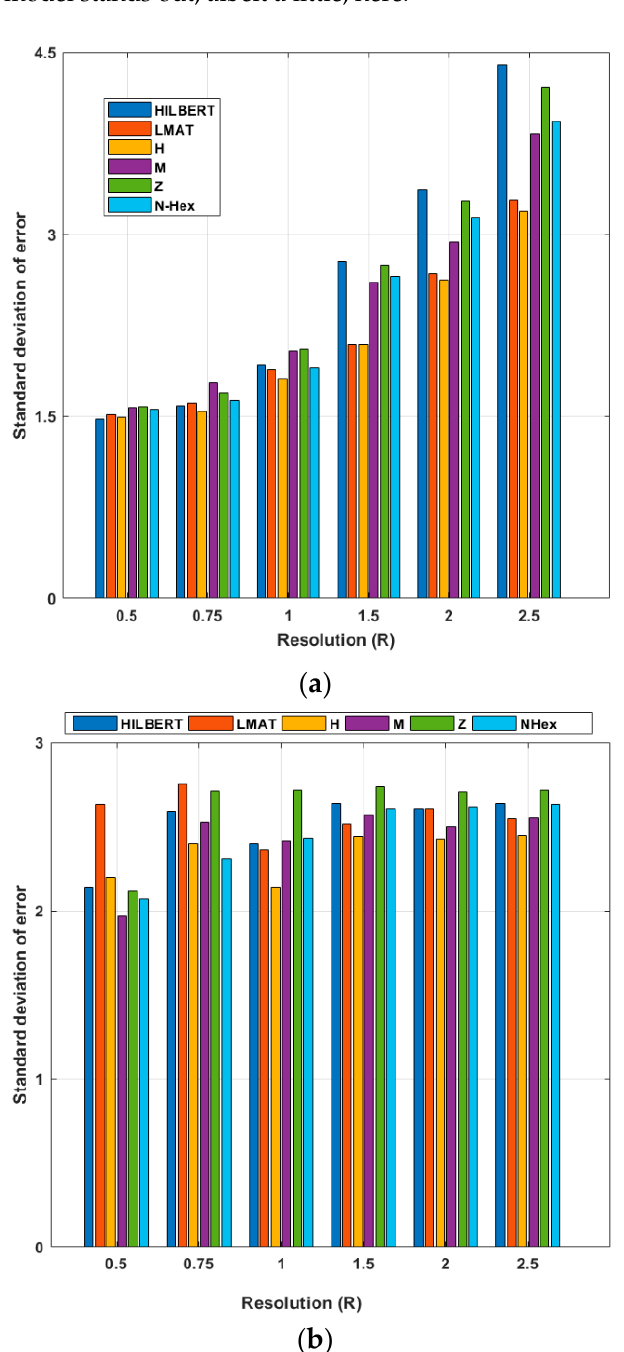
Figure 15. Std of errors of the path planning models according to resolution ( σ = 7) ( a ) WCL, and ( b ) APT.